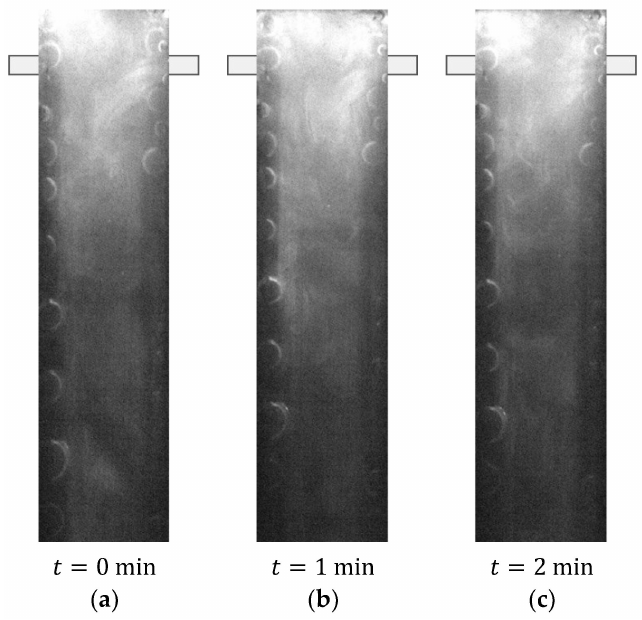
Figure 11. PLIF image obtained with Oxi-RPLIF method at Re =